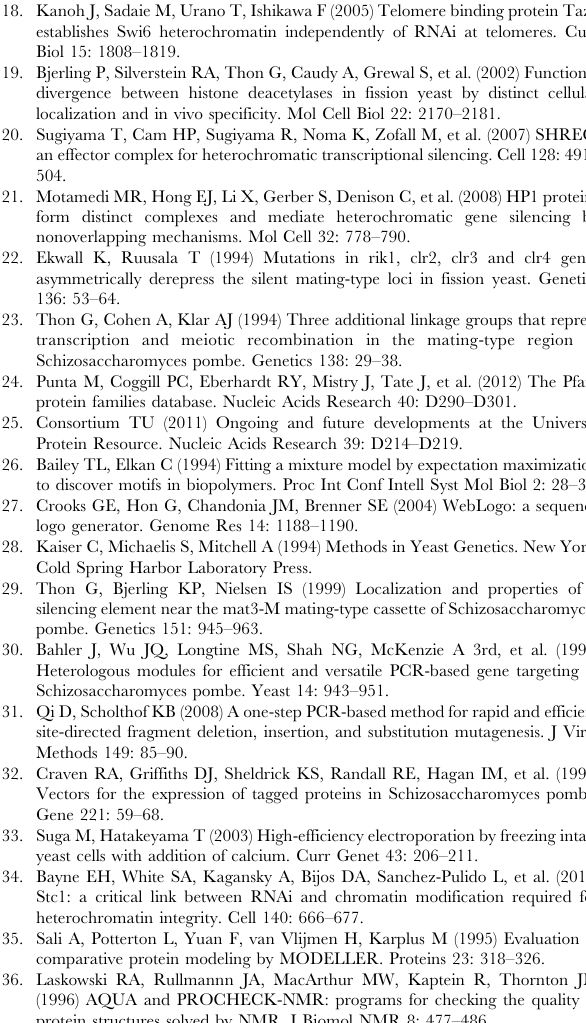
Table S1 List of S. pombe strains used in this study. Table S2 List of PCR-primers used in this